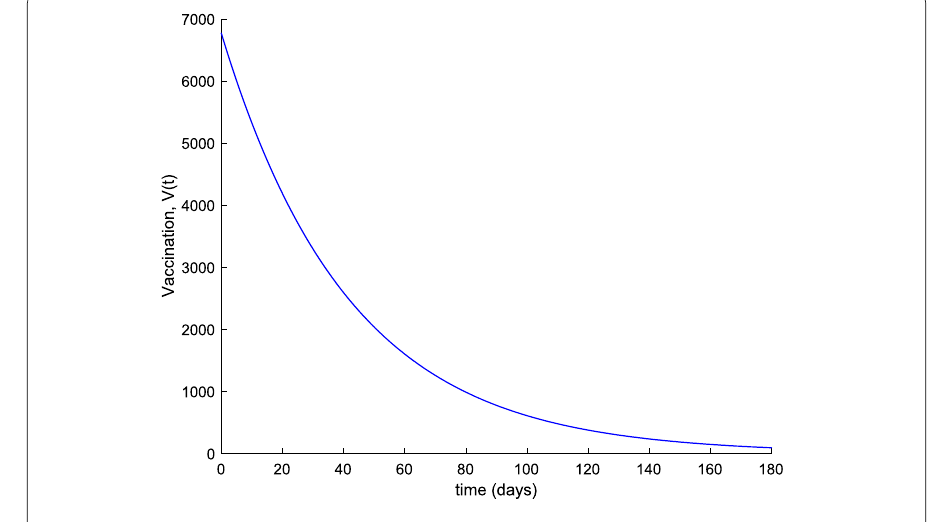
Figure 15 Vaccination action when k V = 0.001 and k T = 0.004